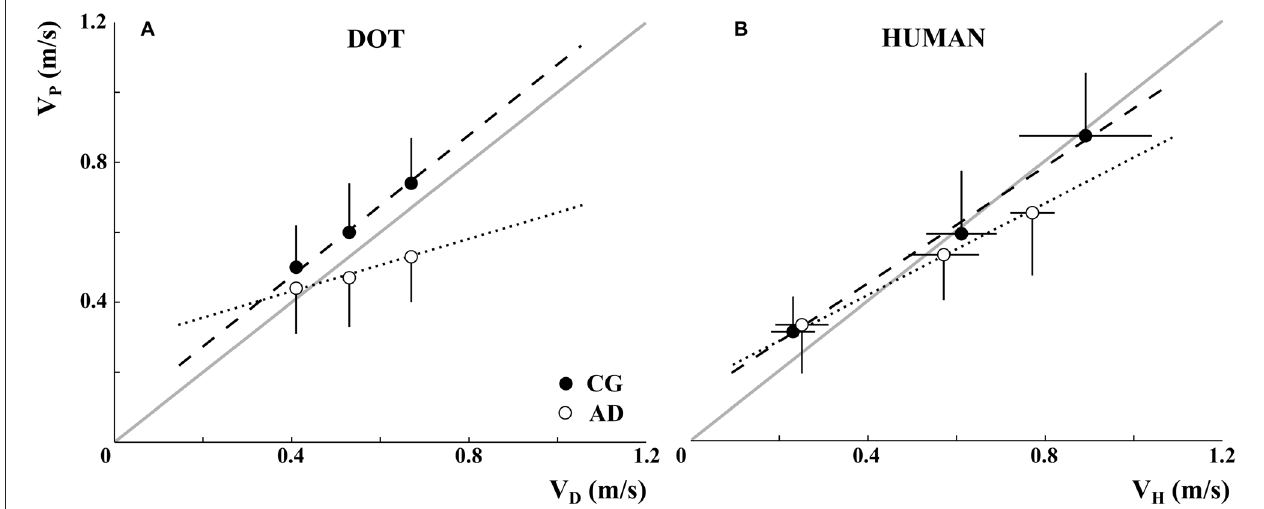
FIGURE 3 | Alzheimer’s disease patients’ (AD-white) and healthy elderly participants’ (control group, CG-black) mean velocities (V P , y-axis) as a function of dot velocity (V D , A; x-axis) and human demonstrator’s velocity (V H , B; x-axis). The data refer to the mean velocities over movement repetitions and the vertical error bar to the standard deviation. It can be noted that the demonstrator’s velocities were actually inaccurate (see the horizontal error bars representing standard deviations). Dotted and dashed lines represent the linear relationship between AD and CG participants and V D,H , while the gray lines correspond to a perfect imitation of the stimuli velocity.